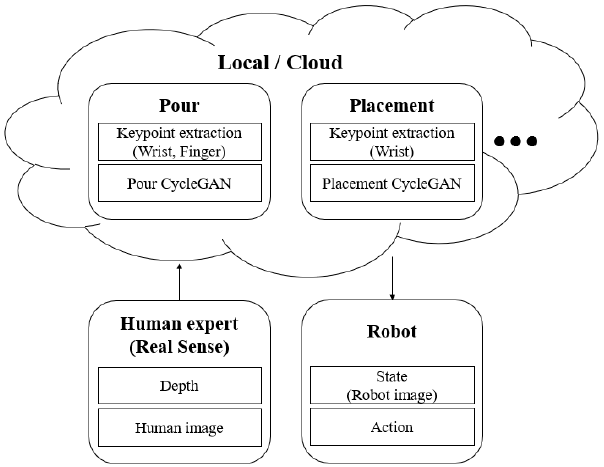
Figure 2. The system